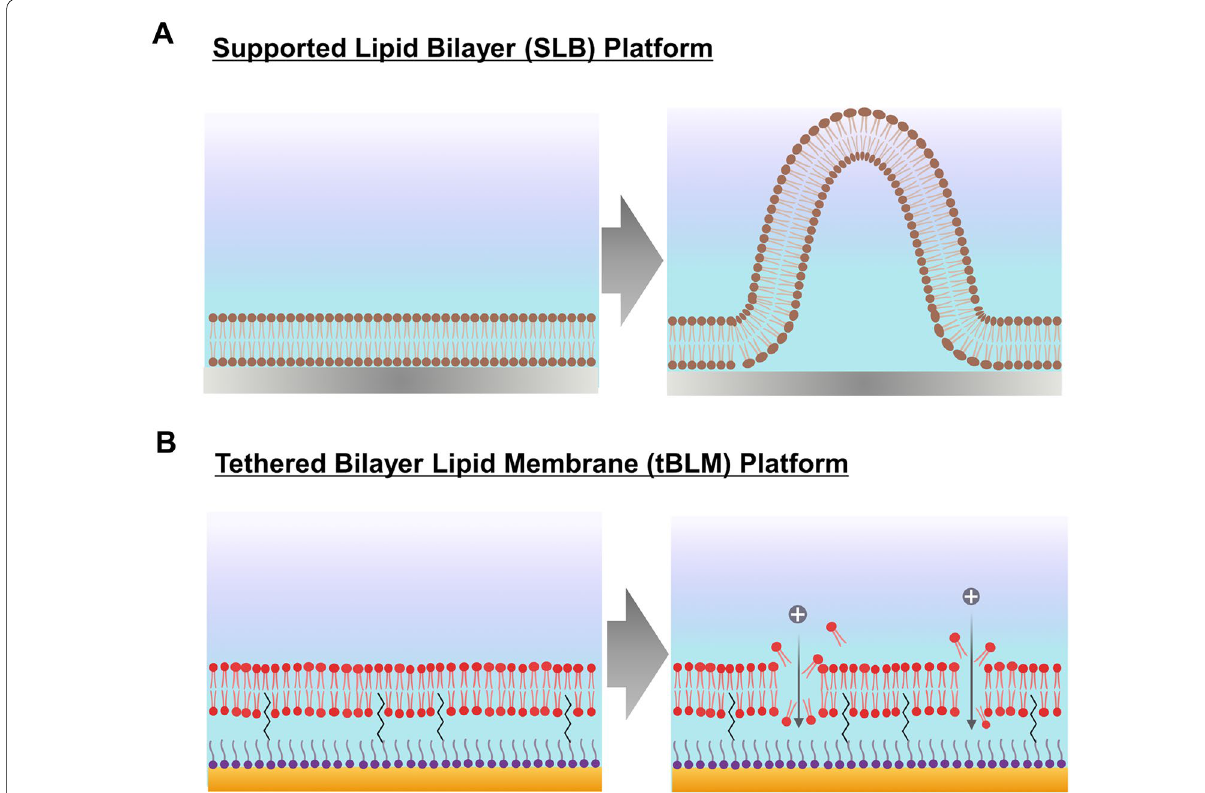
Fig. 1 Schematic illustration of nanoarchitectonics‑based model membrane platforms for characterizing membrane‑disruptive interactions of antimicrobial lipids. A Supported lipid bilayer (SLB) platform enables tracking membrane morphological changes when used in conjunction with the quartz crystal microbalance‑dissipation (QCM‑D) technique. B Tethered bilayer lipid membrane (tBLM) platform enables tracking ionic permeability changes when used in conjunction with the electrochemical impedance spectroscopy (EIS)